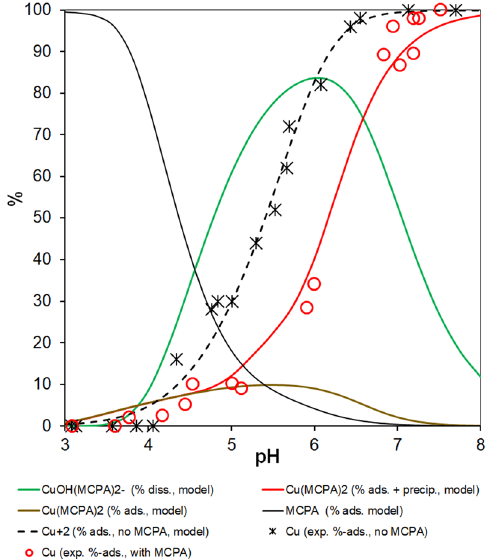
Figure 1. MCPA and Cu speciation in Cu–MCPA–goethite systems (5 g L − 1 goethite, 0.5 mmol L − 1 Cu and/or 1.0 mmol L − 1 MCPA). The solid and dotted lines are the model curves. The asterisks are experimental data for the binary Cu–goethite system without MCPA, the red open dots are experimental data for the ternary system Cu–MCPA–goethite. The red curve is for polymerization and shows the percentage of the Cu(MCPA) 2 complex that precipitated to give almost no dissolved Cu at pH > 7 in the batch equilibrium